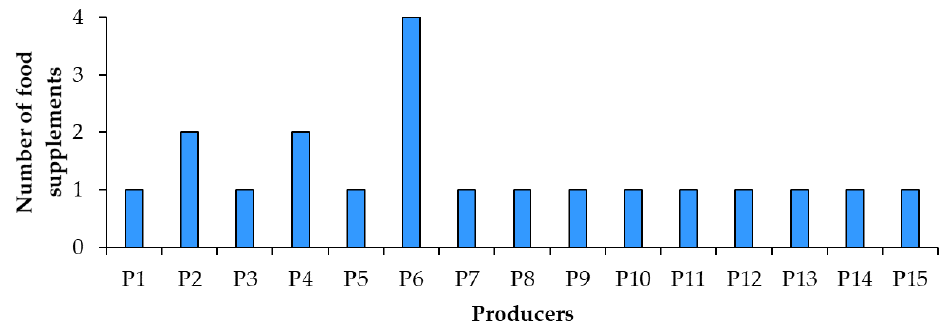
Figure 1. Number of food supplement products and producers.